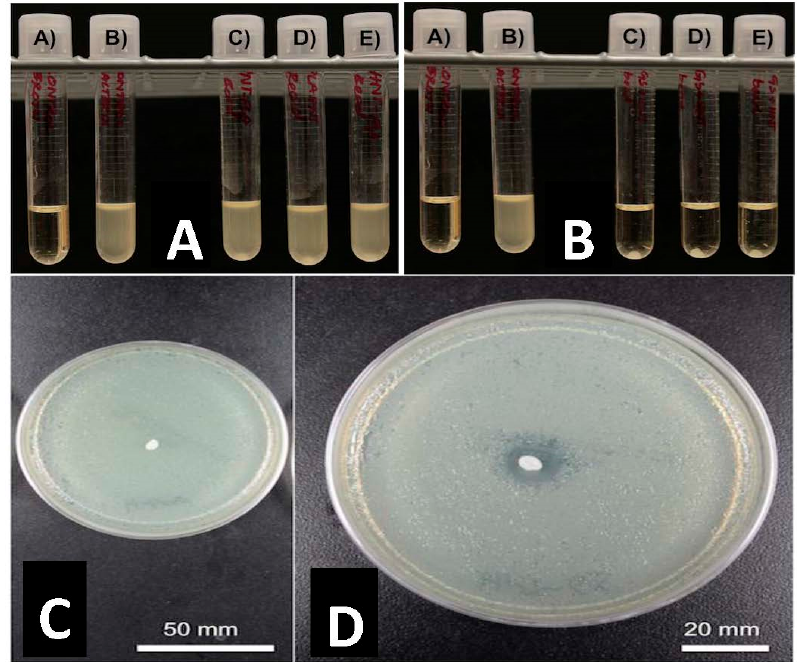
Figure 3. PLA pellets growth inhibition studies. ( A ): (A) Sterile broth; (B) E. coli inoculated broth’ (C–E) 10 wt % HNT-coated PLA pellets in broth culture. ( B ): (A) sterile broth; (B) E. coli inoculated broth’ (C–E) 1.5 wt % gentamicin loaded HNT-coated PLA pellets in broth culture. ( C ): 10 wt % HNT-coated PLA pellet on Mueller Hinton plate. ( D ): 1.5 wt % gentamicin loaded HNT-coated PLA pellets on Mueller Hinton plate.